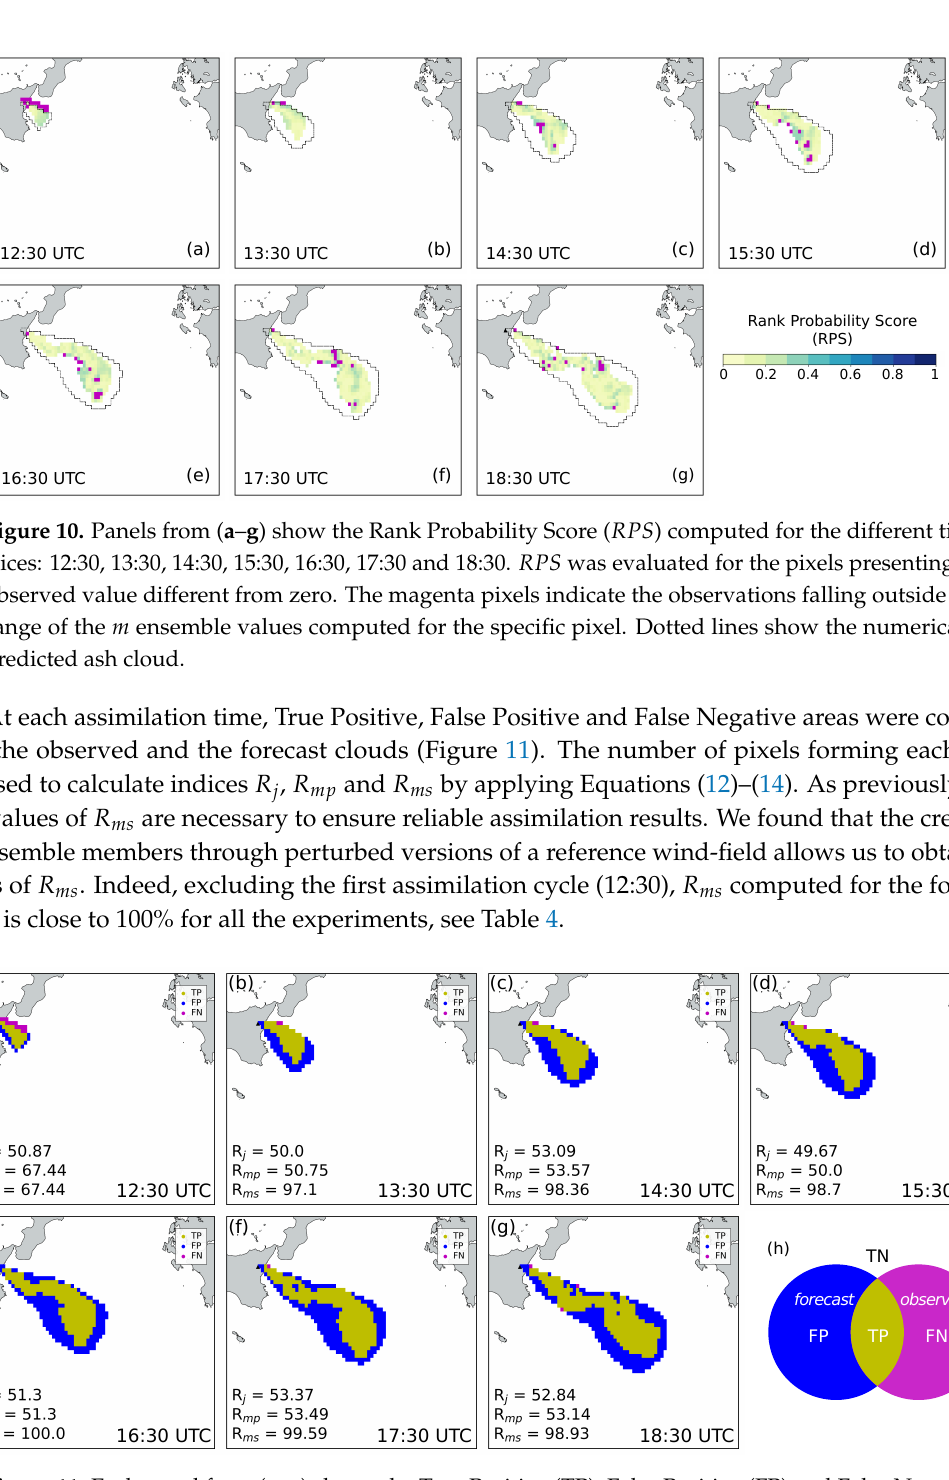
Figure 11. Each panel from ( a – g ) shows the True Positive (TP), False Positive (FP) and False Negative (FN) regions computed for each time slice. The number of pixels forming each region is used to compute indices R j , R mp and R ms . Panel ( h ) shows the definition of such regions, with the blue area representing the forecast cloud, the magenta area the observed cloud and yellow area the common area between the forecast and the observed